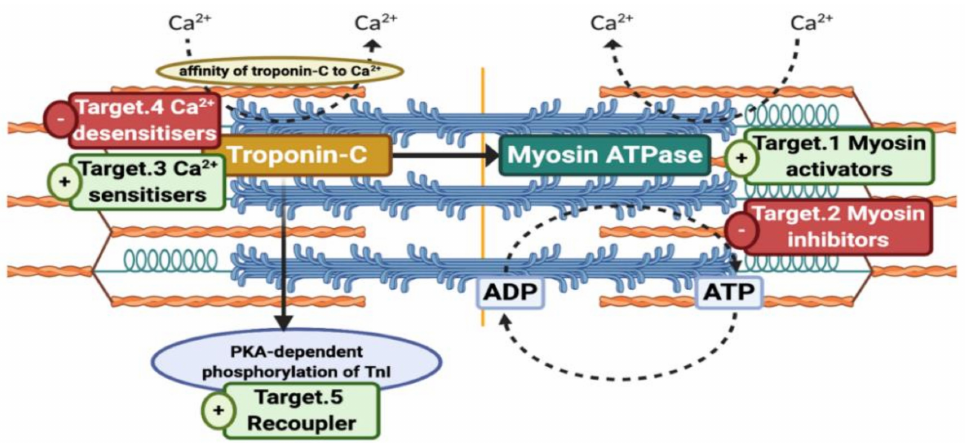
Figure 1. Five potential therapeutic targets in the contractile apparatus for small molecules. Original figure was made by using BioRender.com. The availability of myosin heads for interaction can be ameliorated via myosin activators or alleviated by myosin inhibitors. Similarly, affinity of troponin C towards Ca 2 + ions can be increased (Ca 2 + -sensitisers) or decreased (Ca 2 + -desensitisers). Protein kinase A (PKA)-dependent phosphorylation of TnI was found to be lost in some forms of hypertrophic cardiomyopathy (HCM) and dilated cardiomyopathy (DCM), but it can be restored via Recouplers. Figure was created by using